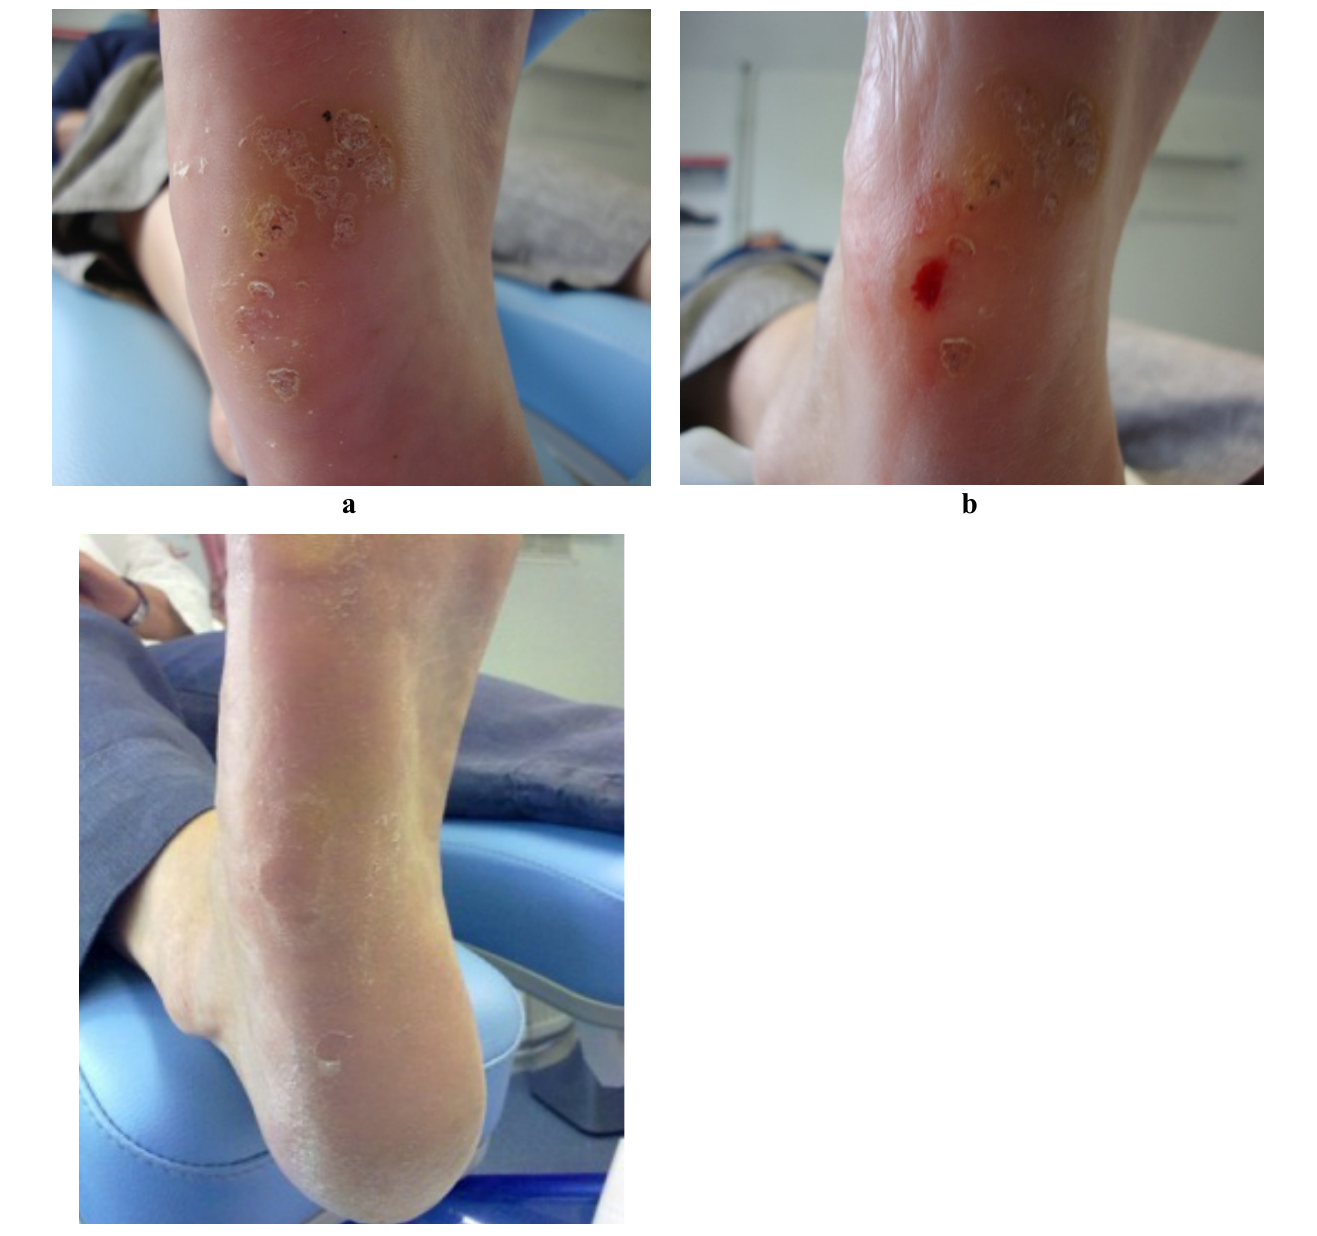
Figure 3. ( a ) Lateral plantar lesion before treatment; ( b ) Same lateral plantar lesion during treatment; ( c ) Same lateral plantar lesion resolved, one month after